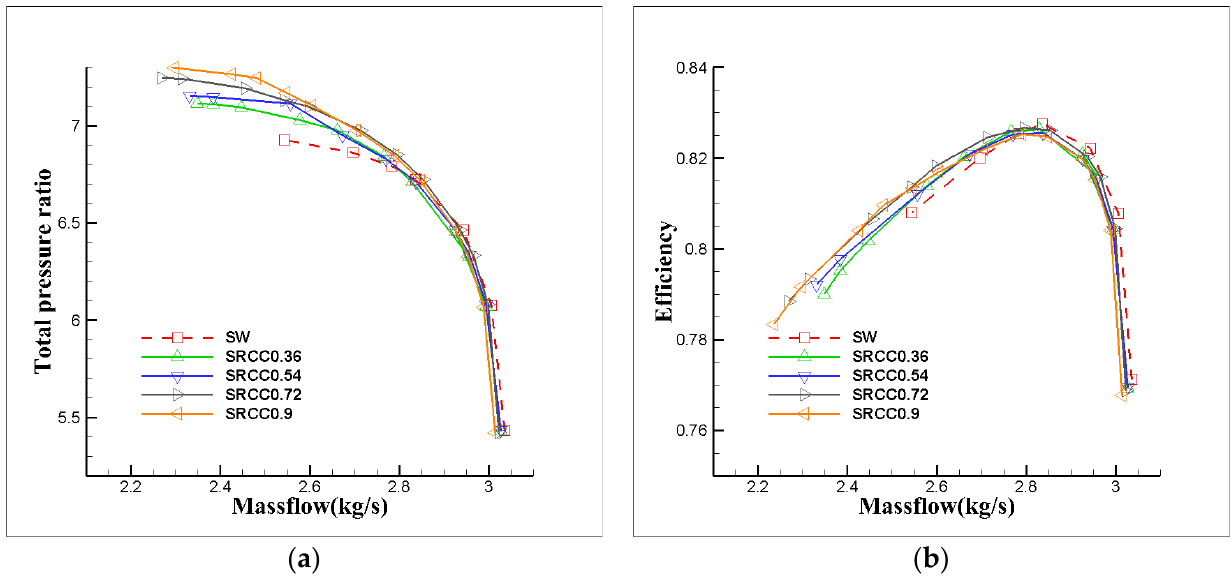
Figure 11. Performance curves of the compressor under different casing parameters. ( a ) Total pressure ratio. ( b ) Isentropic efficiency.